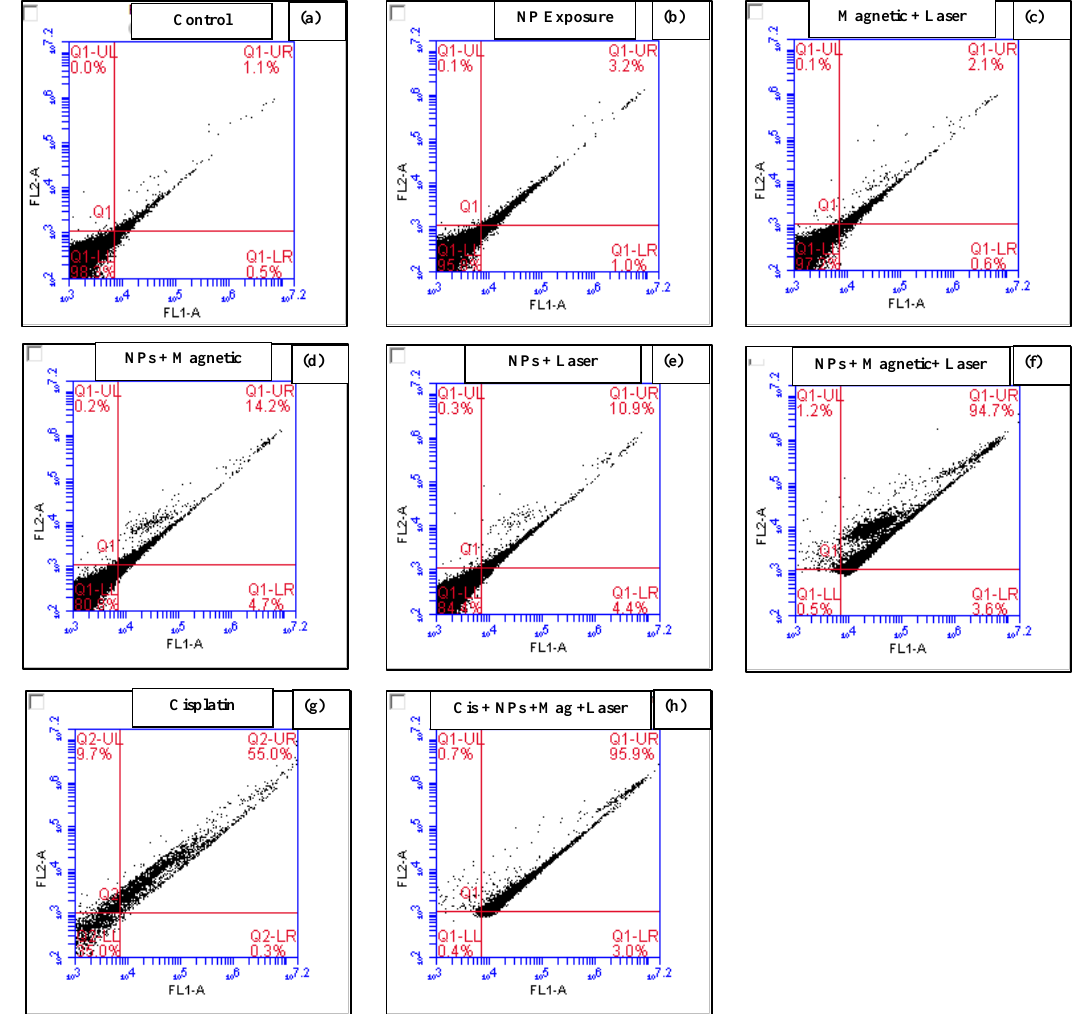
Figure 5. Apoptosis detection by the Annexin V assay. In four windows of each plot, the lower left indicates normal cells, the lower right indicates early apoptotic cells, the upper right indicates middle phase apoptotic cells, and the upper left indicates late phase apoptotic cells or necrotic cells. Irradiation/exposure parameters where applied: AC magnetic field intensity was 60 Oe, frequency was 120 kHz, and laser power was 300 mW (at 520 nm); NPs: (400 µ g/mL MNP + 2 µ g/mL AuNP); CPNPs 200 µ